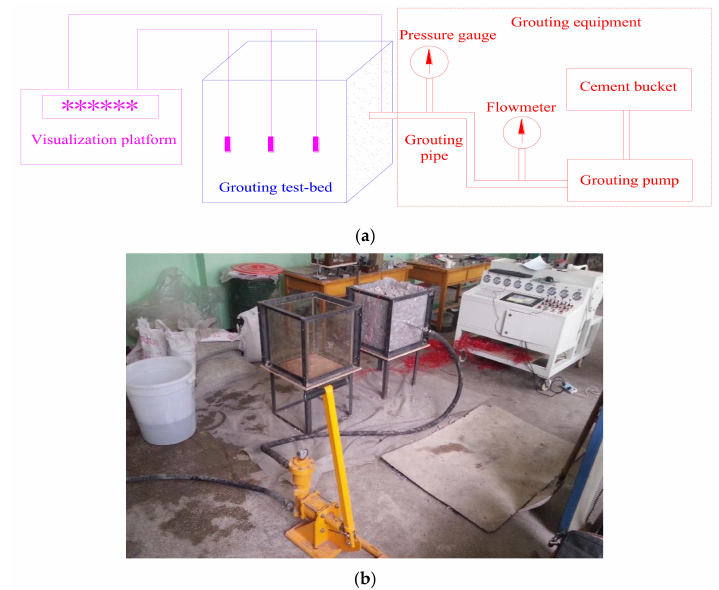
Figure 2. The overall arrangement of the three-dimensional visualization grouting experiment system: ( a ) Sketch Map; ( b ) Practicality